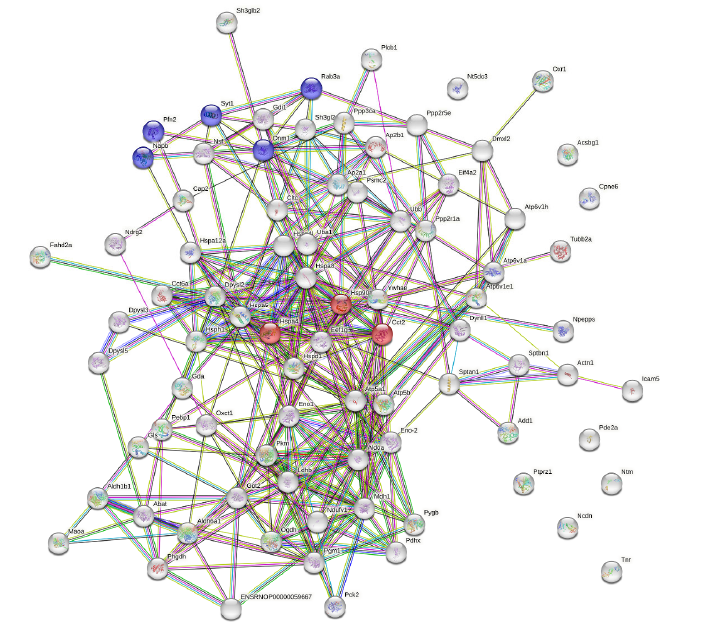
Figure 2. STRING ‐ based detection of modified biological pathways among synaptosomal differentially upregulated proteins following Flx treatment in CSIS rats; in blue, proteins involved in regulation of synaptic vesicle cycle; in red, proteins involved in regulation of chaperone ‐ mediated protein complex assembly; Napb–beta ‐ soluble NSF attachment protein; Rab3a–Ras ‐ related protein Rab ‐ 3A; Dnm1–dynamin ‐ 1; Syt1–synaptotagmin ‐ 1; Pfn2–profilin ‐ 2; Hsp90aa1–heat shock protein HSP 90 ‐ alpha; Hspa4–heat shock 70 kDa protein 4 ‐ like (predicted); Cct2–T ‐ complex protein 1 subunit beta.